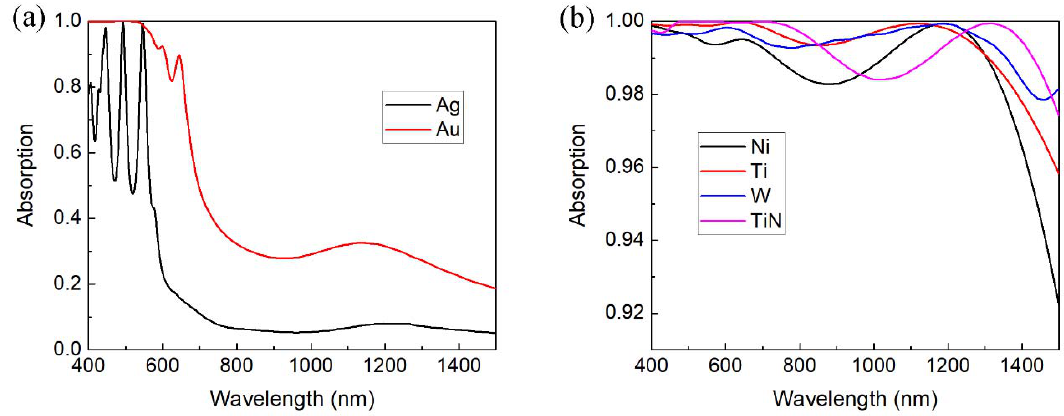
Figure 6. ( a ) Absorption spectra of nanocone MPA based on noble metals gold (Au) and silver (Ag); ( b ) absorption spectra of nanocone MPA with refractory TiN or metals.